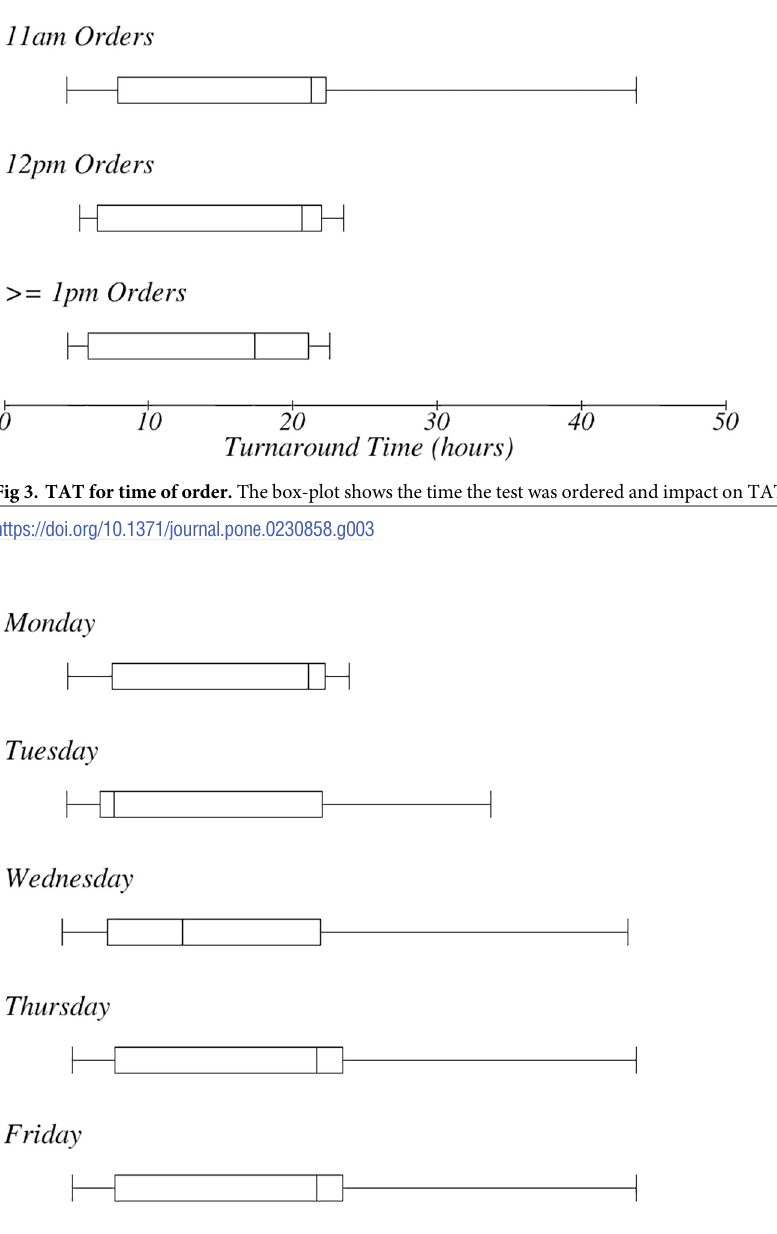
PLOS ONE | https://doi.org/10.1371/journal.pone.0230858 April 8,